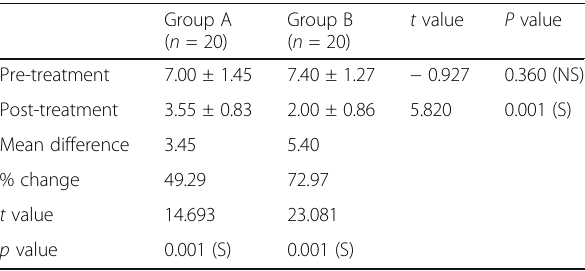
Table 4 Comparison of mean values of flexion of lumbar spine within and between both